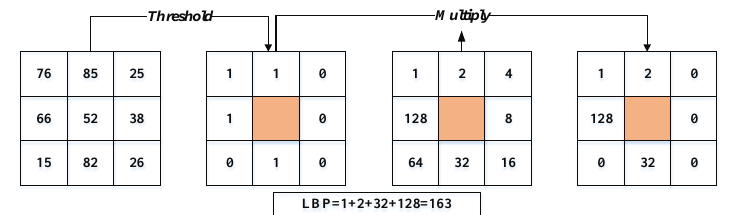
Figure 3. The local binary pattern (LBP) descriptor [19].